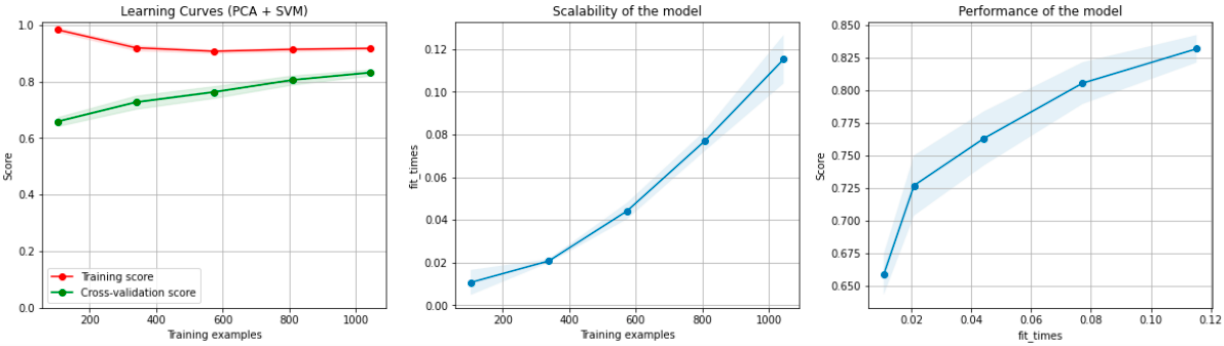
Figure 7. Learning curves, scalability and model performance for the PCA + SVM algorithm, for the non-overlapping dataset.